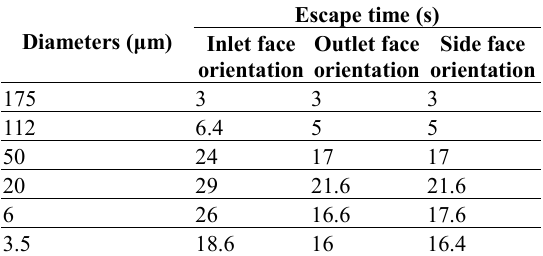
Figure 7 . The bar chart of the induced wind and no-wind configurations. (a)X-Displacement and (b)Escape time